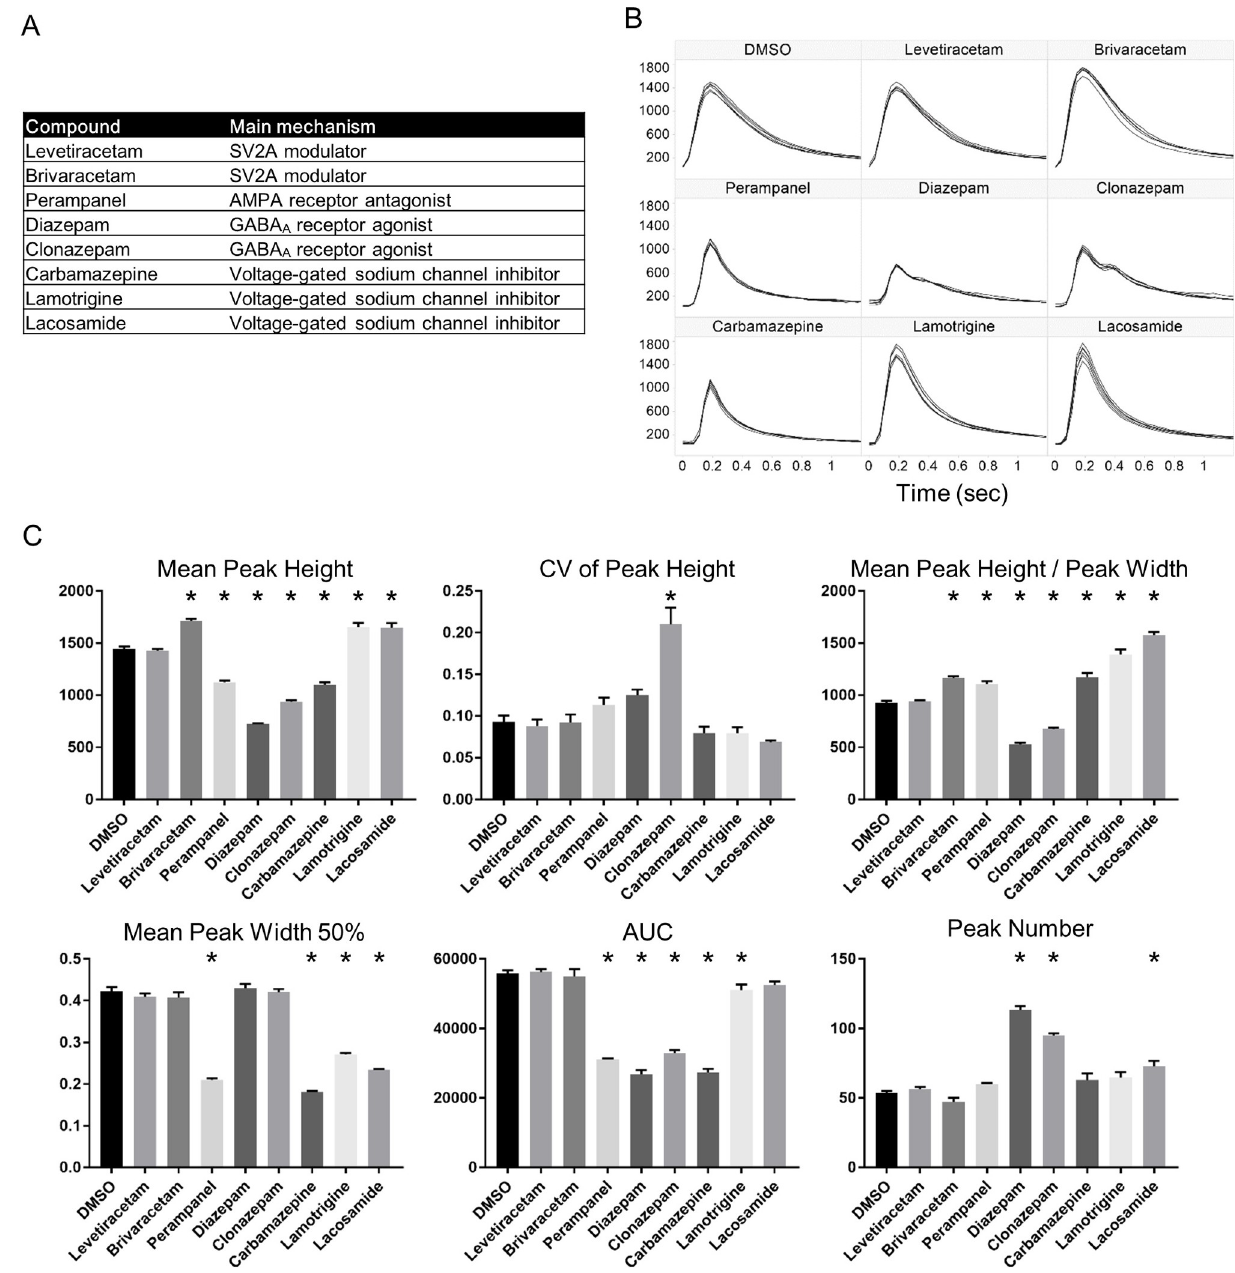
Fig 2. The changes of wave features in response to treatment with AEDs. (A) Summary of the AEDs used in our calcium oscillations assay. (B) Overlaid traces of peaks of calcium oscillations exposed to DMSO and AEDs. A trace represents an normalized trace in a well. X-axis represents peak heights in arbitrary units (a.u.), while y-axis represents time in seconds. (C) Bar plots of features extracted from wells to which AEDs were applied. Features were calculated from 6 wells per AED containing DMSO. Data are means ± SEM (n = 6 wells). p * < 0.05 vs. DMSO (n = 40–123 peaks per well, one-way ANOVA with Dunnett post-hoc